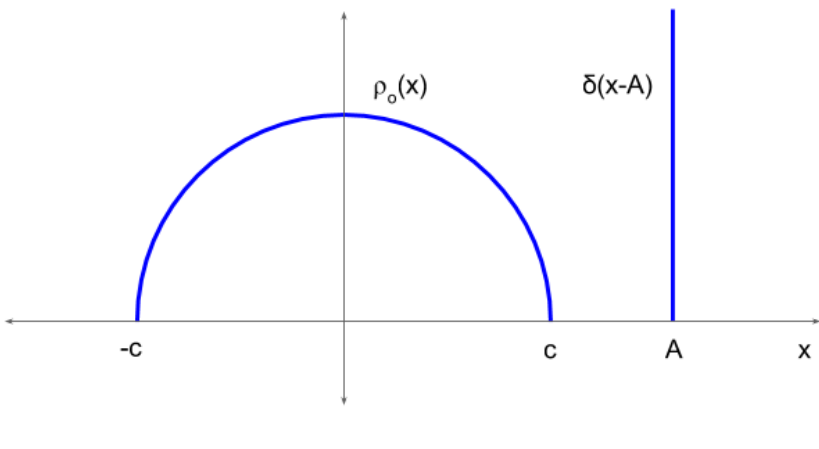
Figure 1: Density distribution in the planar